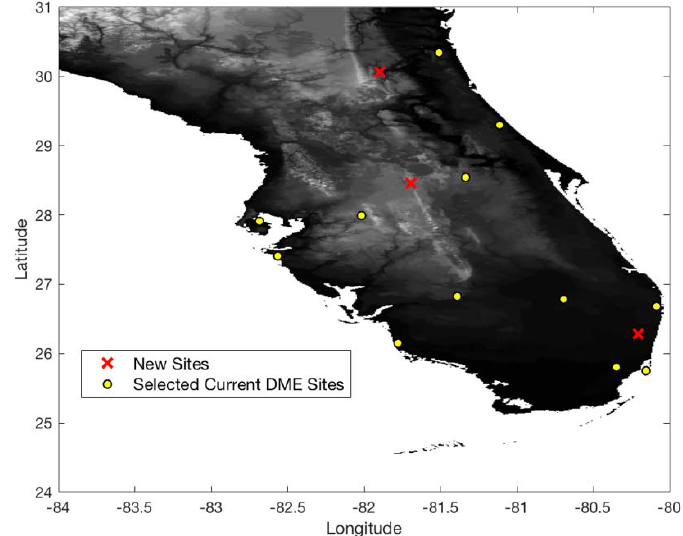
Figure 10. Optimal DME transponder network for 0.3 nm positioning accuracy with DME/S.